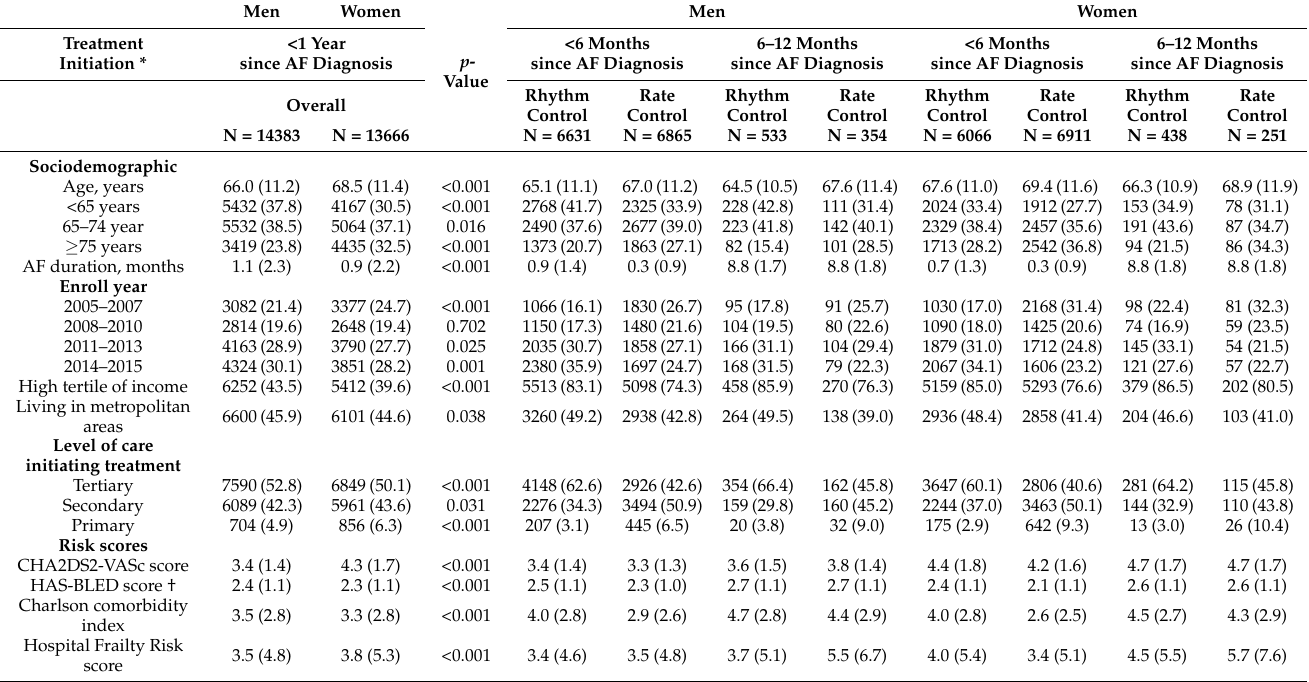
Table 1. Baseline characteristics of men and women treated with rhythm- or rate control before overlap